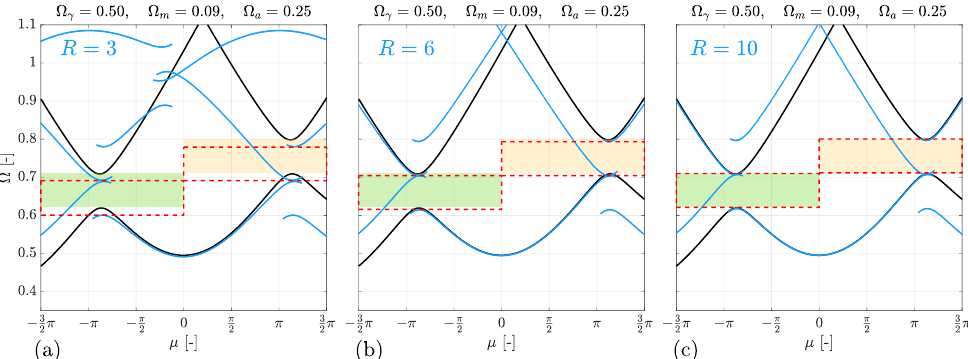
Figure 4. Comparison between the dispersion diagrams of a rod (black line) and of its spring-mass chain discretization (blue line), using R = 3, 6, 10 masses ( a – c ). Directional band-gaps predicted with the rod model are highlighted in green and yellow, while the band-gaps of the spring-mass chain system are enclosed in dashed red boxes.